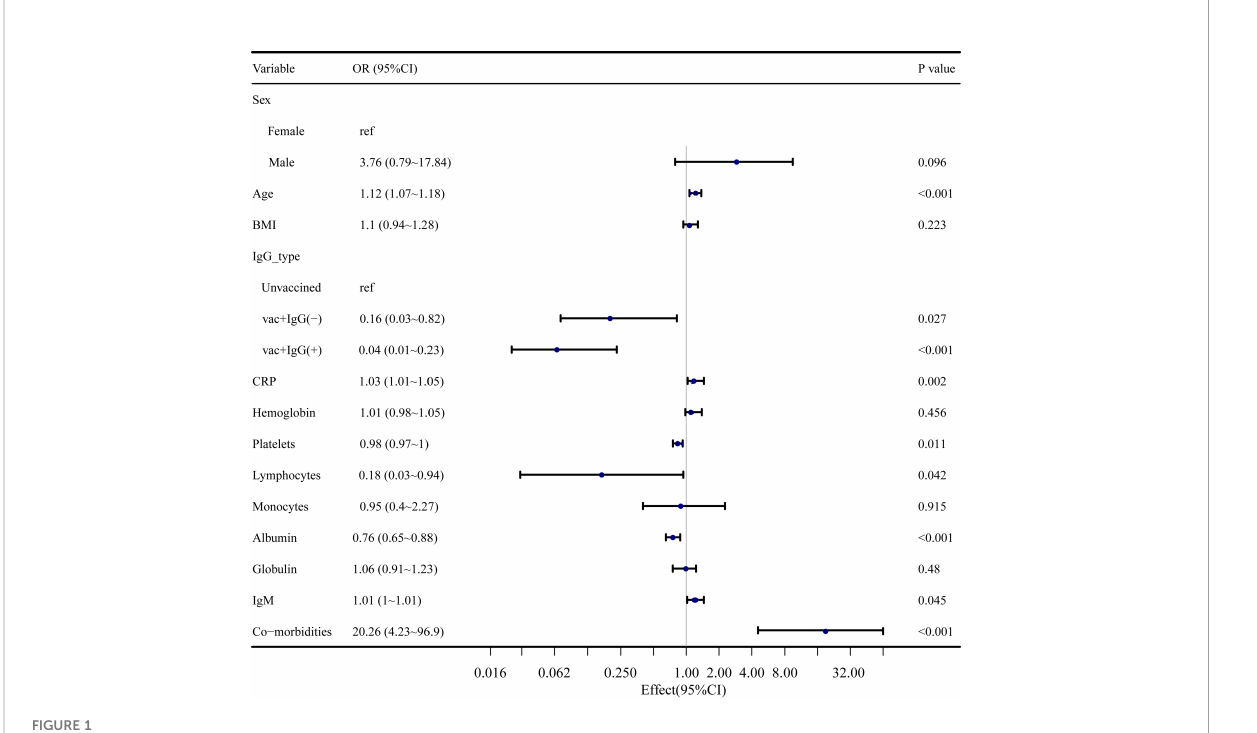
FIGURE 1 Univariate analysis of risk factors of severe cases.